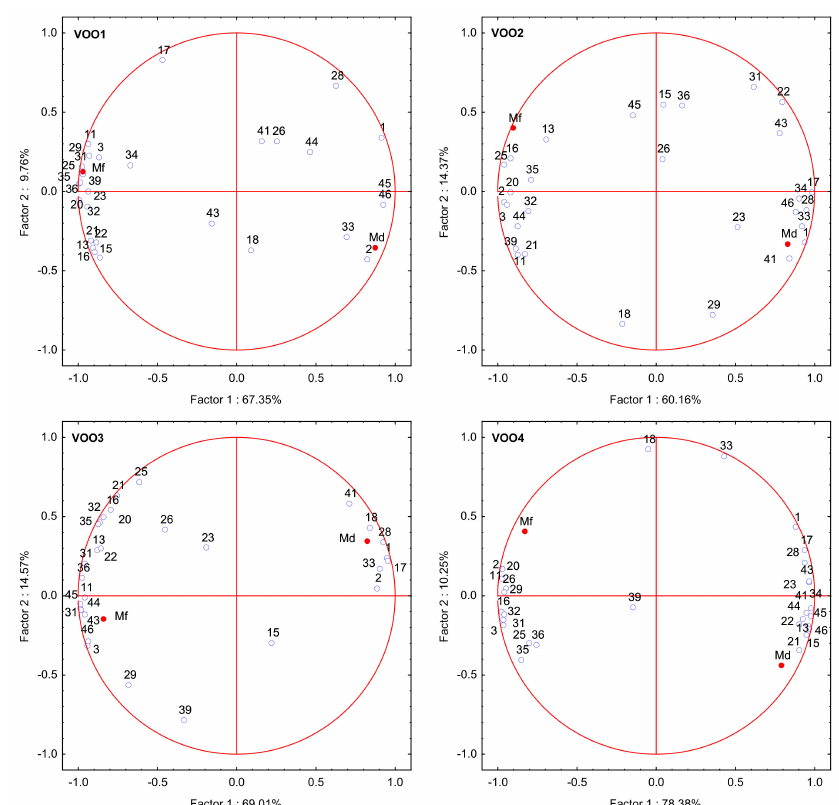
Figure 5. Principal component analysis plots (PCA) of volatile compounds that showed significant changes ( p < 0.05) and RSD% > 50% in the storage experiment, the median of the fruity attribute (Mf) and the median of defect (Md) for the storage time. An individual plot was performed for each virgin olive oil (VOO). Note. Codes are indicated in Table